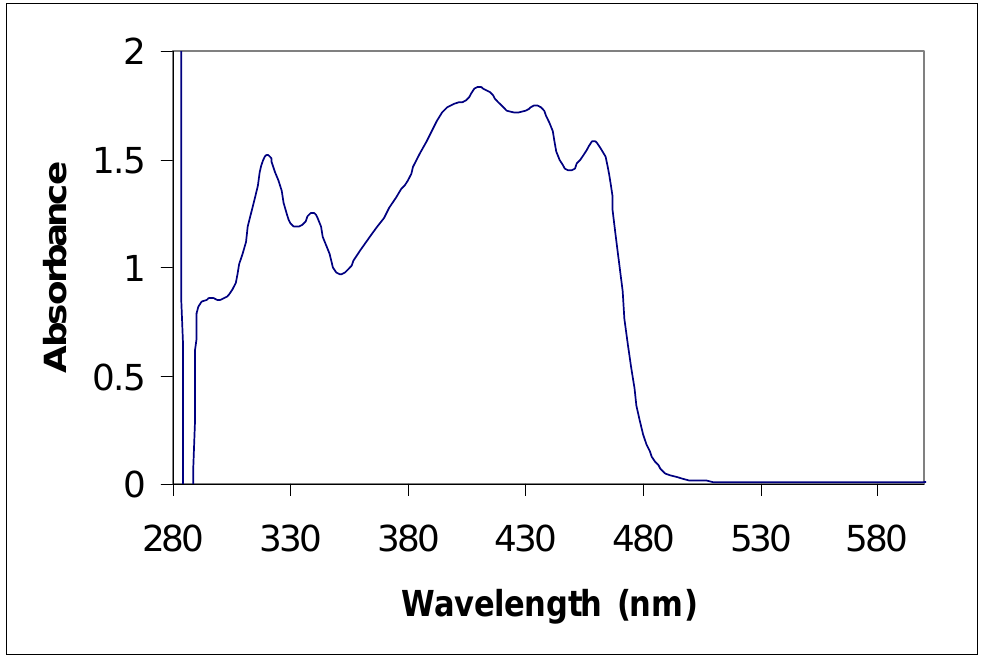
Figure 1. UV-Visible spectra of compound 5a in toluene.